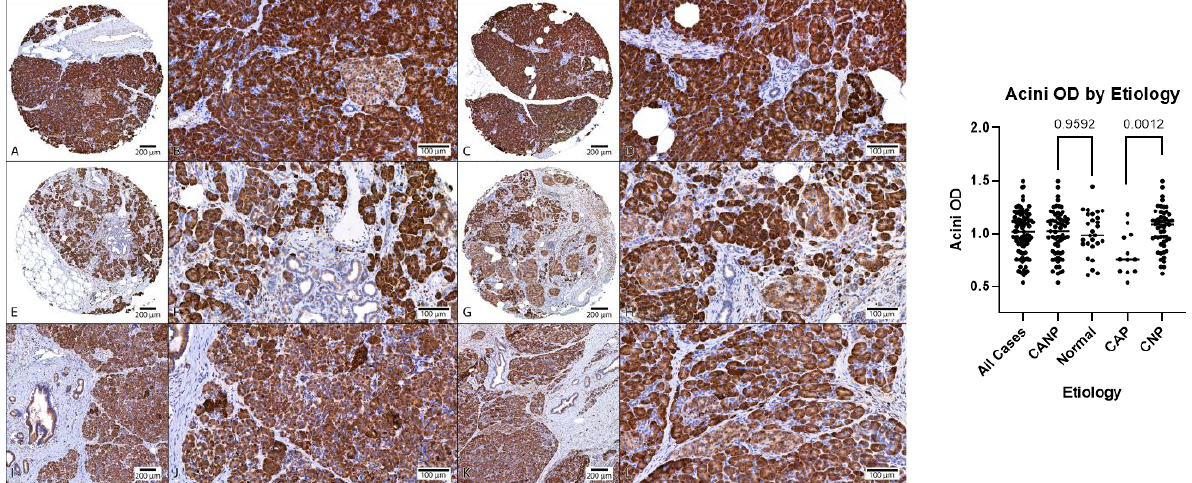
Figure 3. Comparison of MANF acini OD, DAB with hematoxylin counterstain. ( A – D ) Representative normal pancreatic tissue (NPT) with acini OD averages of 0.94 and 1.11 (NPT average of 1.00). ( E – H ) Representative chronic non-alcoholic pancreatitis (CNP) with acini OD averages of 1.02 and 0.96, respectively (CNP cohort average of 1.04). ( I – L ) Representative chronic alcoholic pancreatitis (CAP) with acini OD averages of 0.75 and 0.81, respectively (CAP cohort average of 0.81). ( A , C , E , G , I , K ) at 40× magnification; ( B , D , F , H , J , L ) at 200× magnification. ( Right ): Dot plot of duct OD estimates, combined genders, with p -values displayed. OD, optical density; DAB, diaminobenzi- dine.